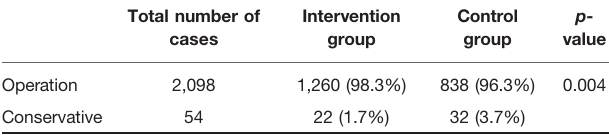
TABLE 3 | Comparison of surgical treatment mode between the two groups.